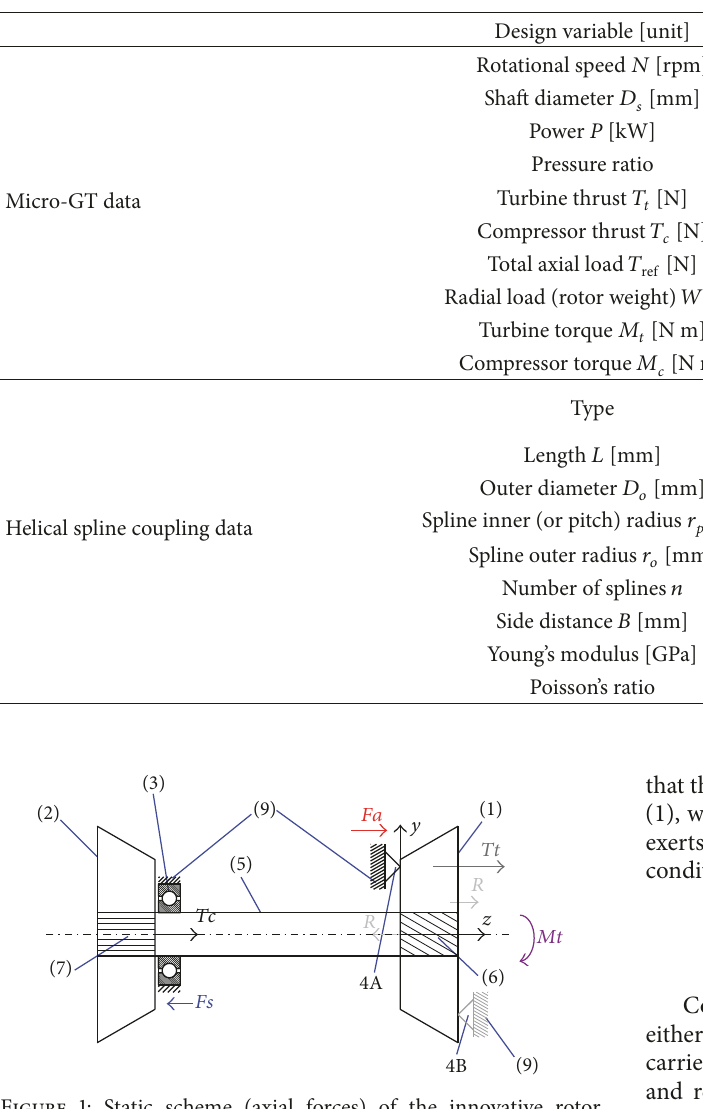
Figure 1: Static scheme (axial forces) of the innovative rotor operating in nominal